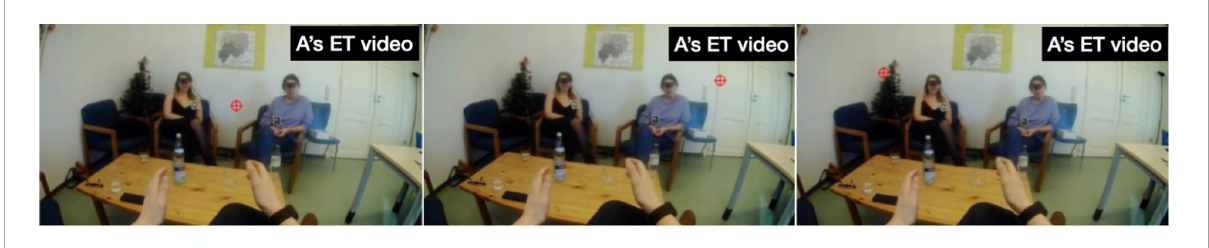
FIGURE8 Storyteller’s gaze movements during silent quote “ ∼ (silent f: blank stare) ∼ ”.